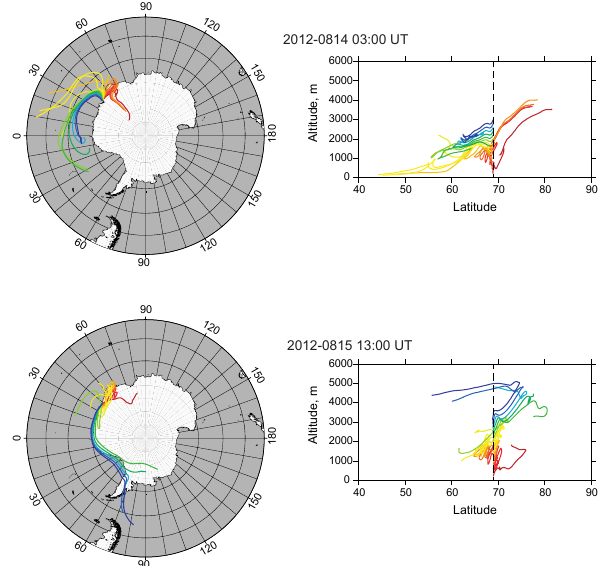
Fig. 3. Examples of 5-day backward trajectory at 03:00UT on 14 August and at 13:00UT on 15 August. Dashed line represents the latitude of Syowa Station (69 ◦ S). Trajectories are color coded to correspond to initial height over Syowa